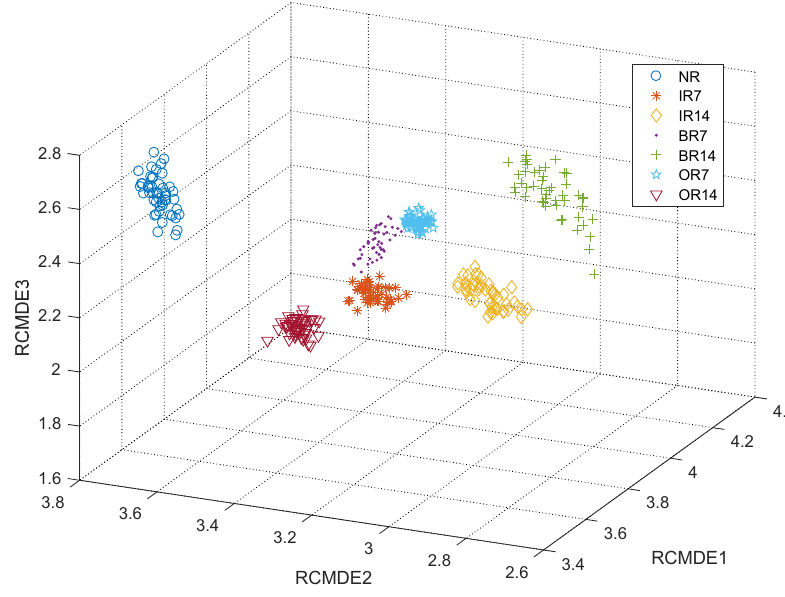
Figure 7. 3D projection of feature vectors for different faults. Table 3. Classification results of various entropies.